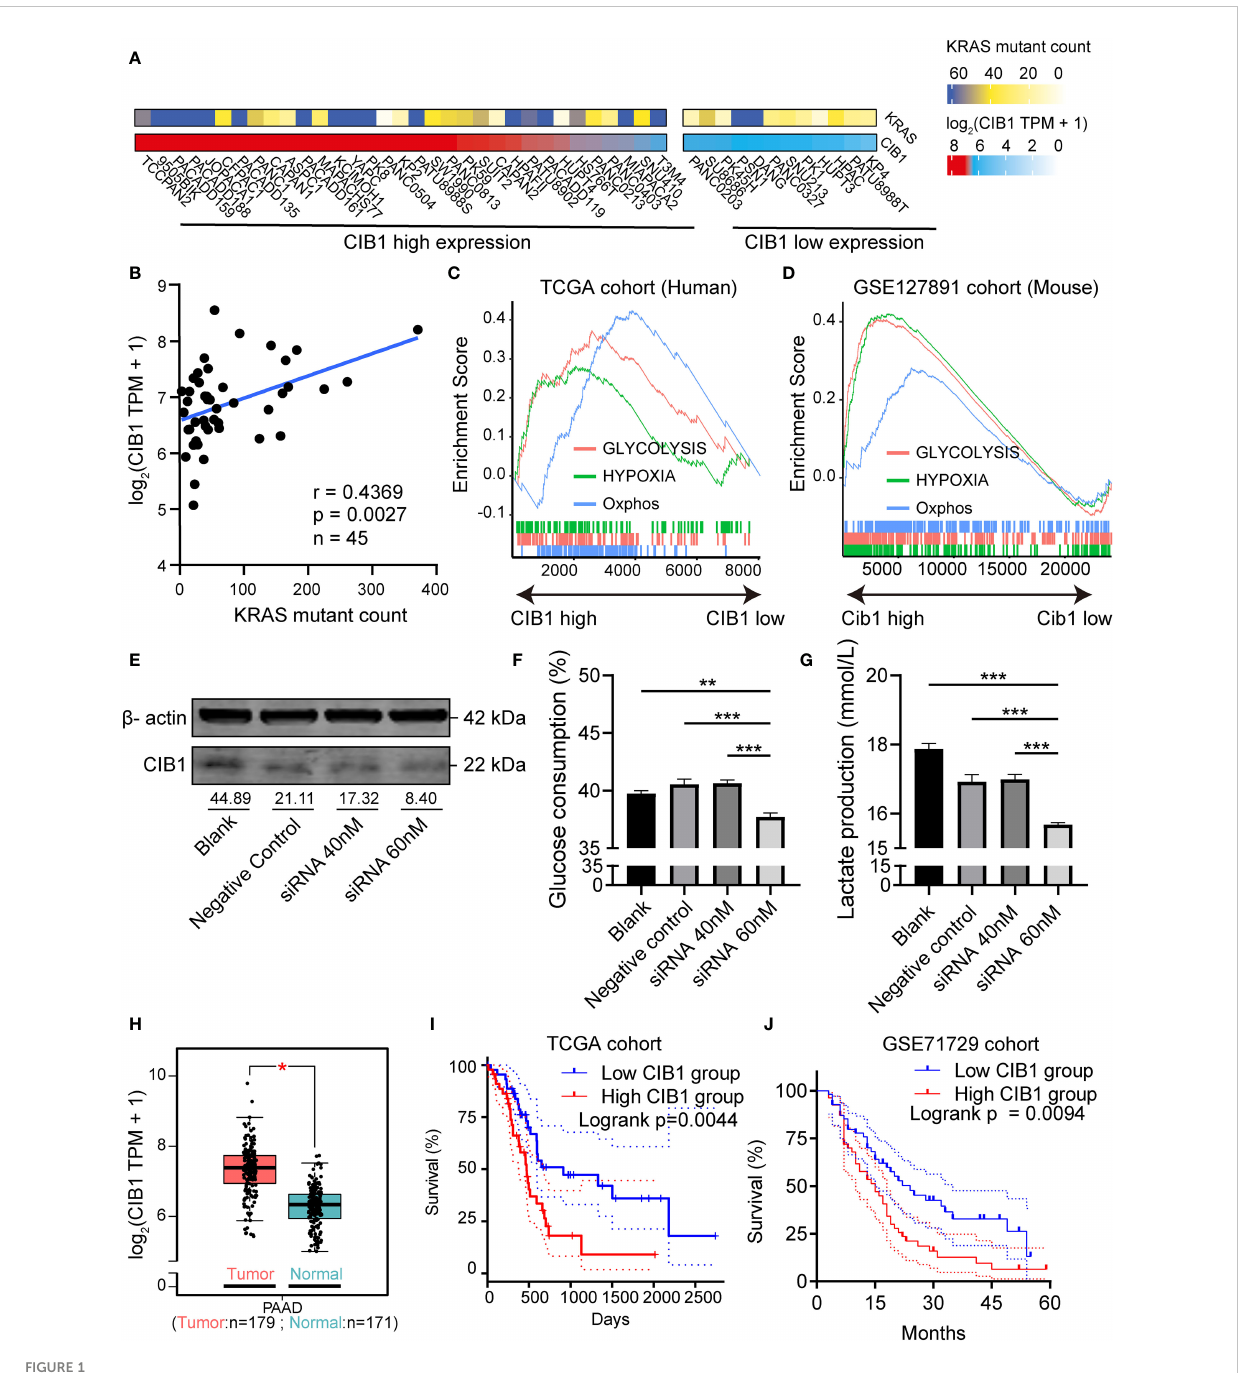
FIGURE 1 Calcium and Integrin Binding 1 (CIB1) was highly co-expressed with KRAS mutation and was related to metabolic reprogramming. (A) Alternative allele counts of KRAS in pancreatic cancer cell lines with different expression level of CIB1. The lower quartile of CIB1 expression in pancreatic cancer cell lines was used as the cutoff to determine the CIB1 expression levels. (B) Correlation scatter plots of alternative counts of KRAS and CIB1 expression. (C) Upregulated HALLMARK signatures in samples with high CIB1 expression. Glucose metabolism-related gene sets are represented as lines of unique color. Gene sets with p< 0.05 were considered signi fi cant, n = 134. (D) Upregulated HALLMARK signature in murine samples with high Cib1 expression,n = 8. (E) Western Blot validation of CIB1 knockdown via siRNA. The mean gray value of bands was measured by ImageJ. (F) Glucose consumption levels decreased under CIB1 knockdown condition. (G) Lactate production levels decreased under CIB1 knockdown condition. (H) Differential expression of CIB1 mRNA expression between pancreatic cancer and normal samples. (I, J) Survival plots of CIB1 in TCGA and GSE71729 datasets. Blue lines represent the survival curve of the low CIB1 expression group, and red lines represent the survival curve of the high CIB1 expression group. In TCGA cohort, n(high) = 45, n(low) = 45. In GSE71729 cohort, n(high) = 54, n(low) = 55 *p< 0.05. **p< 0.01, ***p<